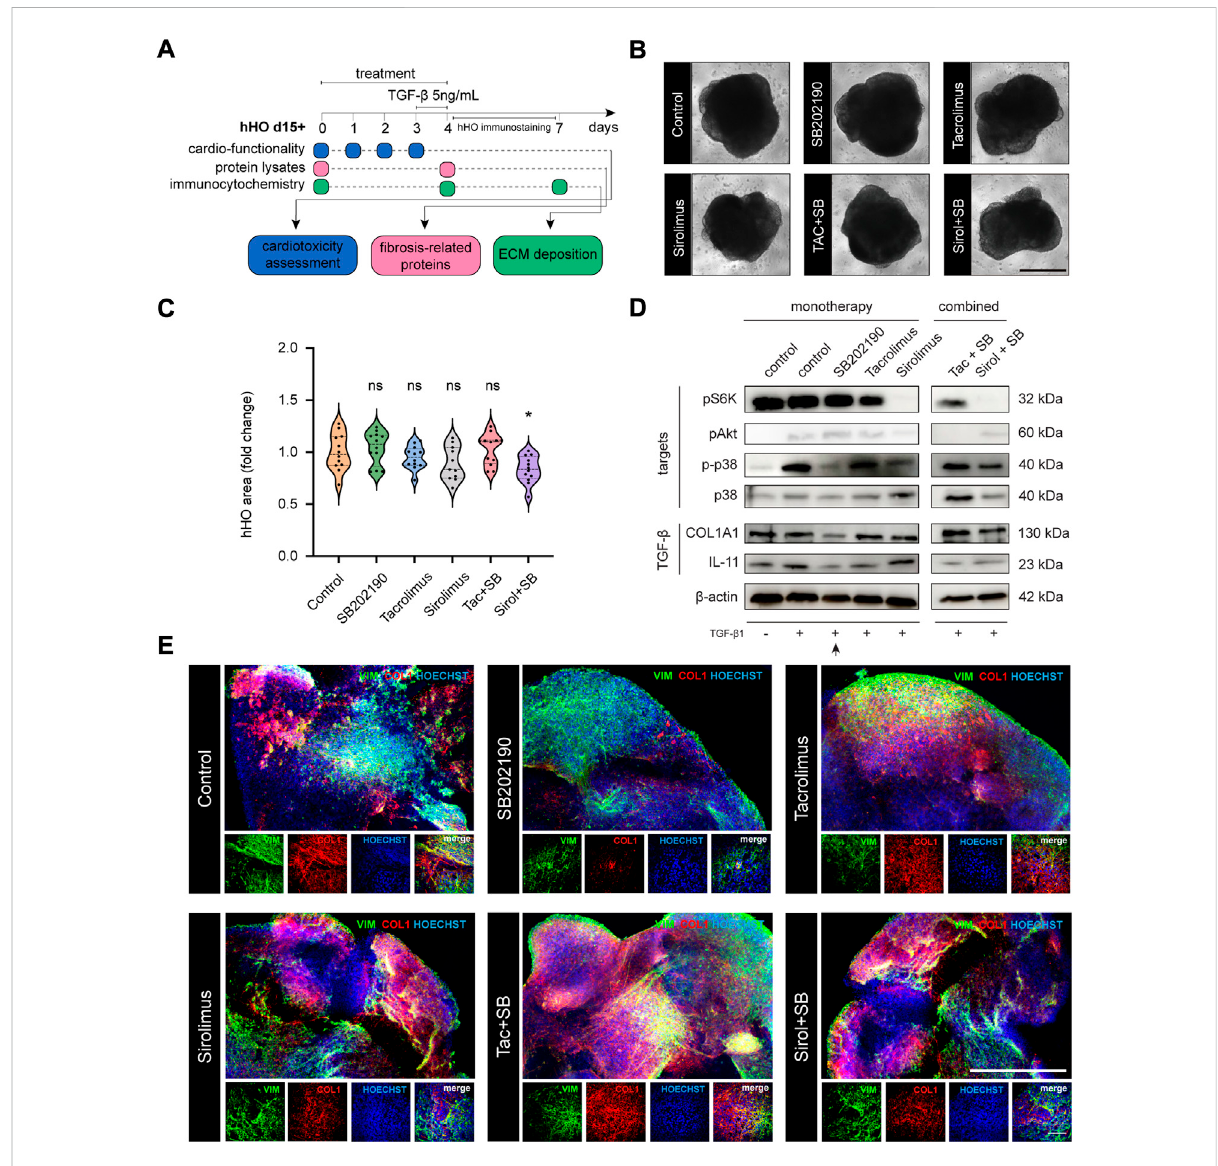
FIGURE 4 Monotherapy and combo-based chemical evaluation of anti fi brotic compounds in human heart organoid modeling reactive fi brosis. (A) Schematic representation of the experimental work fl ow in hHOs. (B) Phase contrast microscopy for hHOs d15 + 3+1 (scale bar: 500 μ m). (C) hHO areasizeafter96 hofcompoundtreatment[relativetocontrol[FC], n ≥ 11,two-tailed,unpaired t -test]. (D) WesternblotanalysisinhHOsforpathway targets upon different treatments and TGF- β 1 stimulation [pS6K, pAkt, p-p38, p38] and TGF- β 1 fi brosis-related responsive genes [COL1A1,